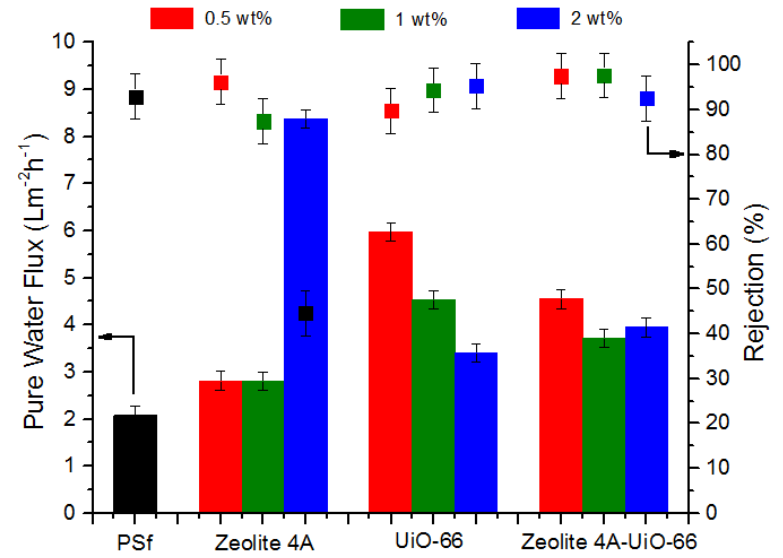
Figure 4. Pure Water Flux and humic acid rejection of neat PSf and MMMs.